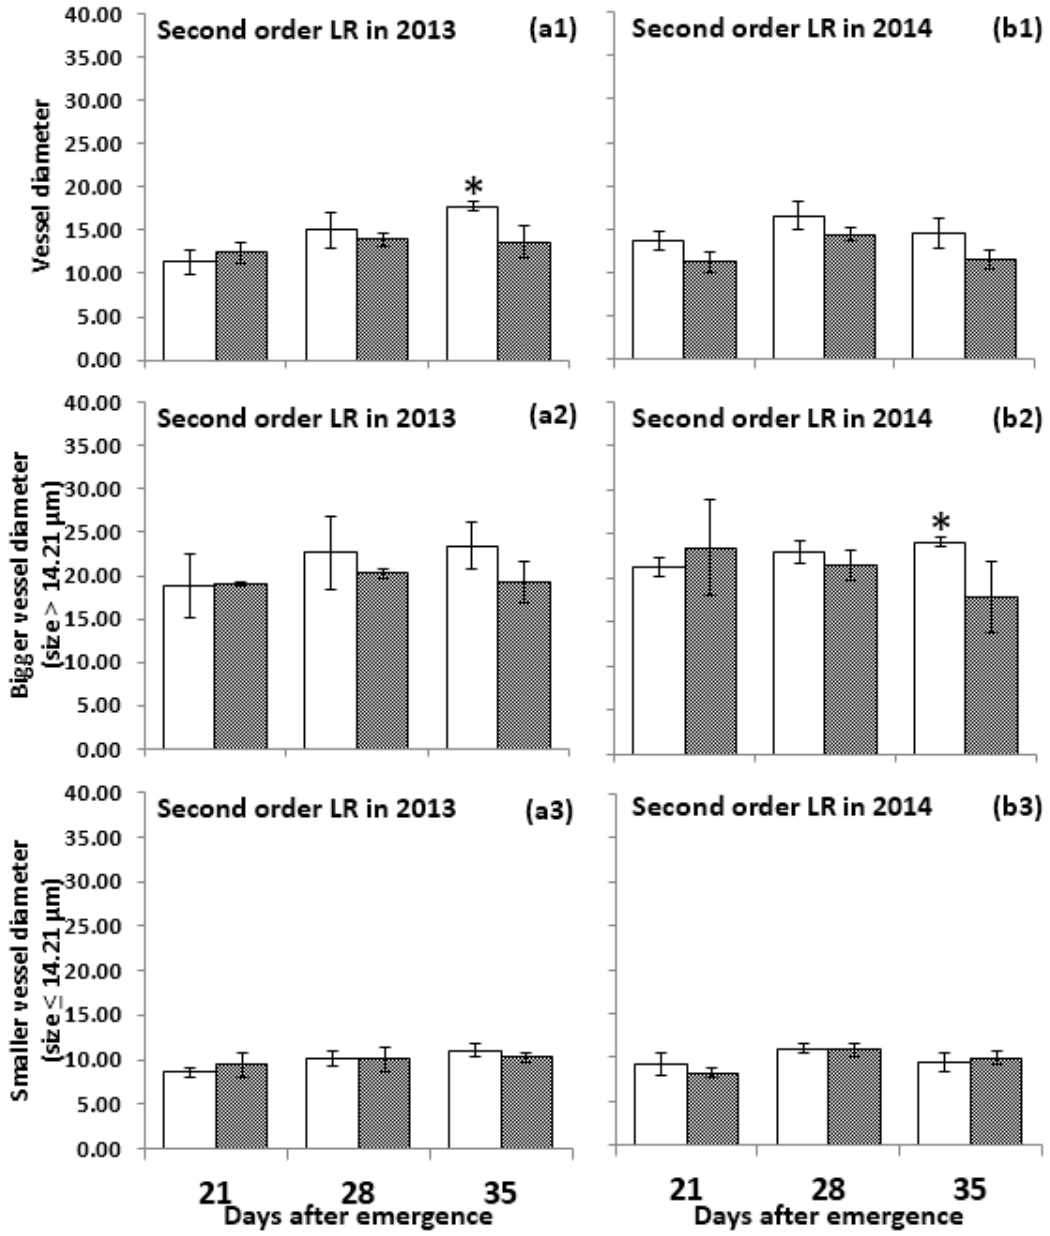
Figure 10. Vessel diameter of second order lateral roots ( a1 , b1 ), bigger vessel diameter ( a2 , b2 ) and smaller vessel diameter ( a3 , b3 ) of peanut at 21, 28 and 35 DAE in 2013 ( a ) and in 2014 ( b ); Significant at * p ≤ 0.05, non-stress treatments ( □ ) and stress treatments ( ■ ). Because stress treatment reduced the diameters of the average xylem vessels and bigger